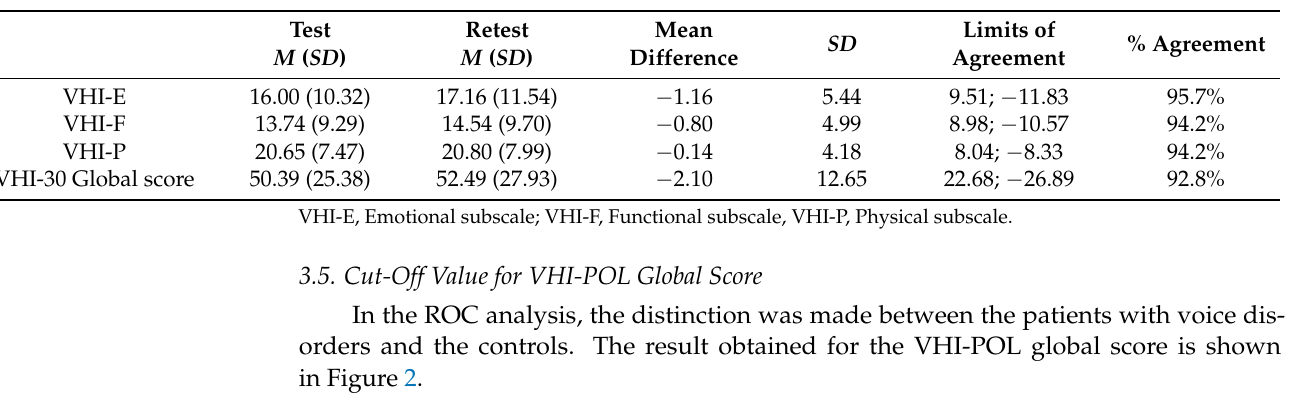
Table 4. Agreement between test and retest of